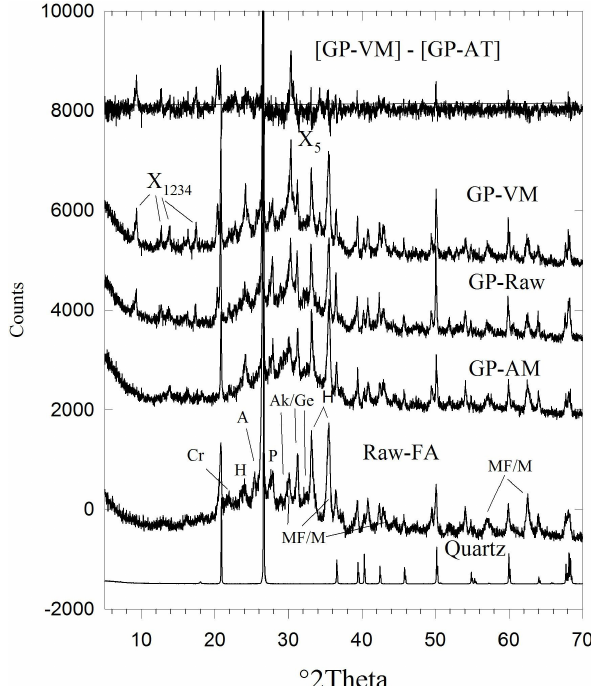
Figure 7: XRD patterns of raw fly ash (Fa-raw) and geopolymer sam- ples prepared from raw and milled fly ashes, GP-AT (attrition milled), GP-FA-raw (raw fly ash used), GP-VM (vibration milled). Identifica- tion: Cr = Crisobalite, H = Hematite, A = Anhydrite, P = Plagioclase, Ak/Ge = Akermanite/Gehlinite, MF/M = Magnesioferrite/Magnetite, Quartz, X 1234 , X 5 = Additional peaks seen only for GP-VM and GP-FA- raw. [GP-VM]-[GP-AT] denotes the difference